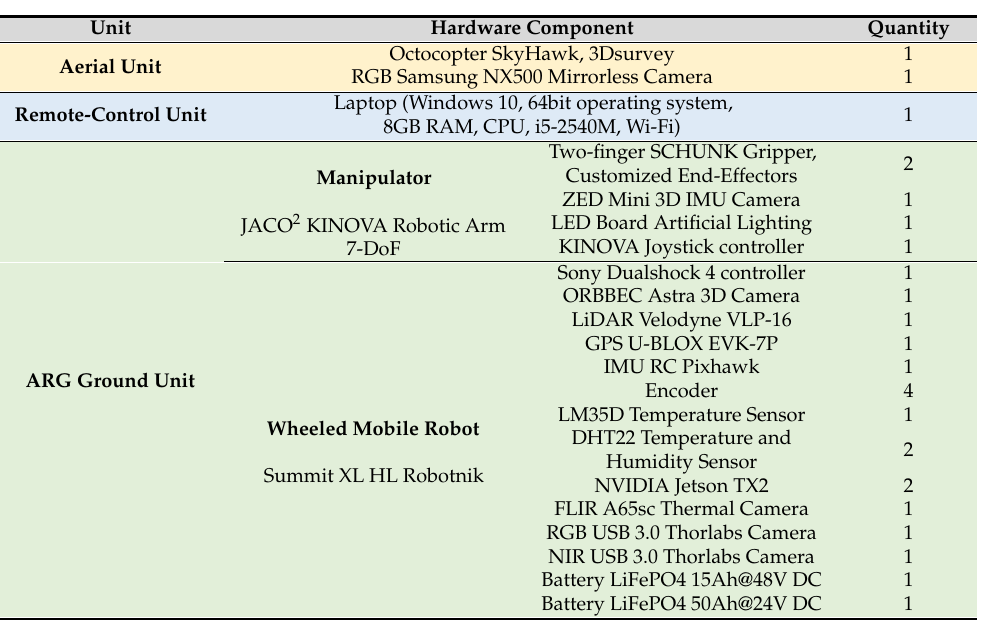
Table 2. Multi-Level Bill of Materials (BOM) of the Proposed